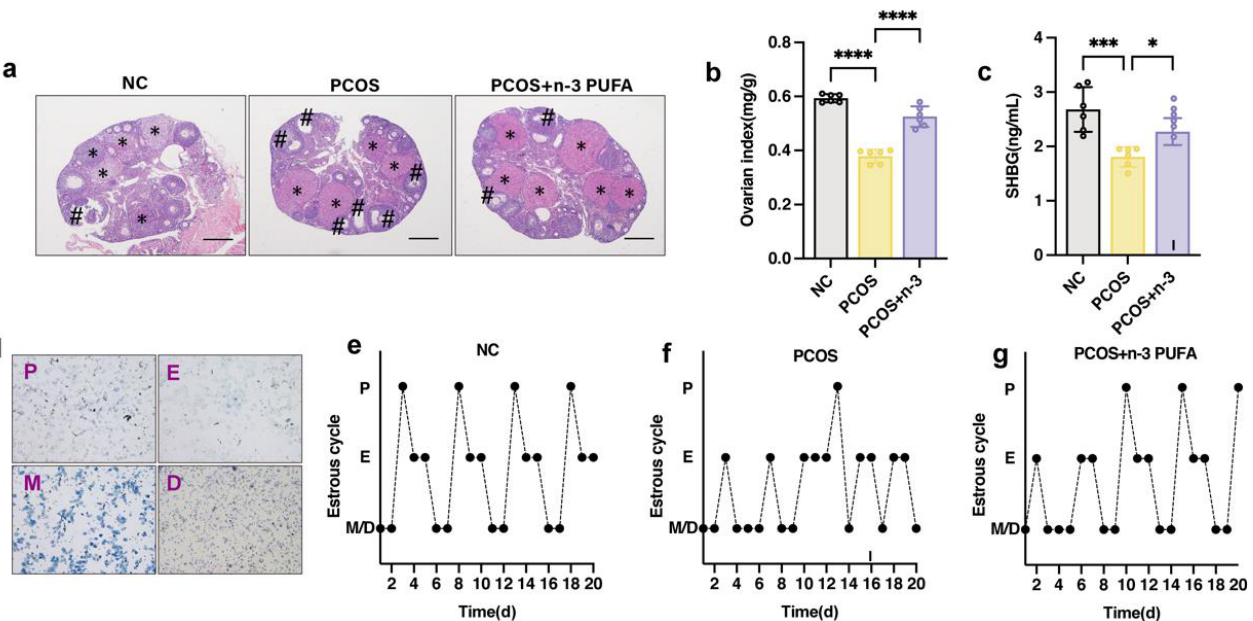
Figure 2. Effect of n-3 PUFA on ovarian tissue morphology and estrous cycle in PCOS mice. ( a ) The impact of n-3 PUFA on the ovary of PCOS mice was detected by the morphology of ovarian tissue detected by HE staining. ( b ) Ovarian index of mice in control, PCOS and PCOS + n-3 treatment groups (Ovary weight mg/Body weight g). ( c ) Serum SHBG level in control, PCOS and PCOS + n-3 treatment groups. ( d ) In order to accurately judge the estrus stage of mice, the vaginal epithelial cells of mice were observed by toluidine blue staining experiment, P for pre-estrus E for estrus M for post-estrus D for interestrus. ( e – g ) Oestrus cycle statistics of mice in control, PCOS and PCOS + n-3 treatment groups. Data are means ± SD (n = 6). * represents corpus luteum ; # represents antral follicle . * p < 0.05, *** p < 0.001, **** p < 0.0001.